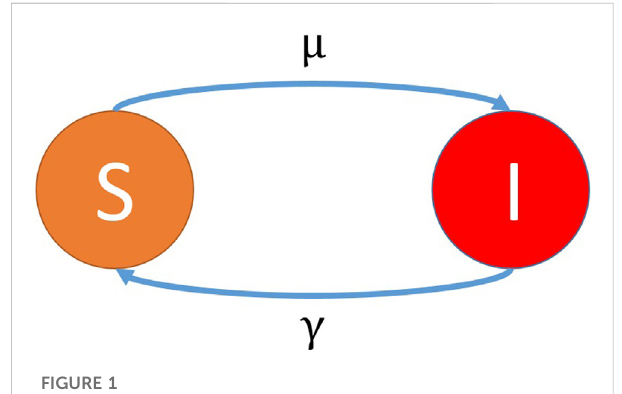
FIGURE 1 Illustration of the adopted SIS model.